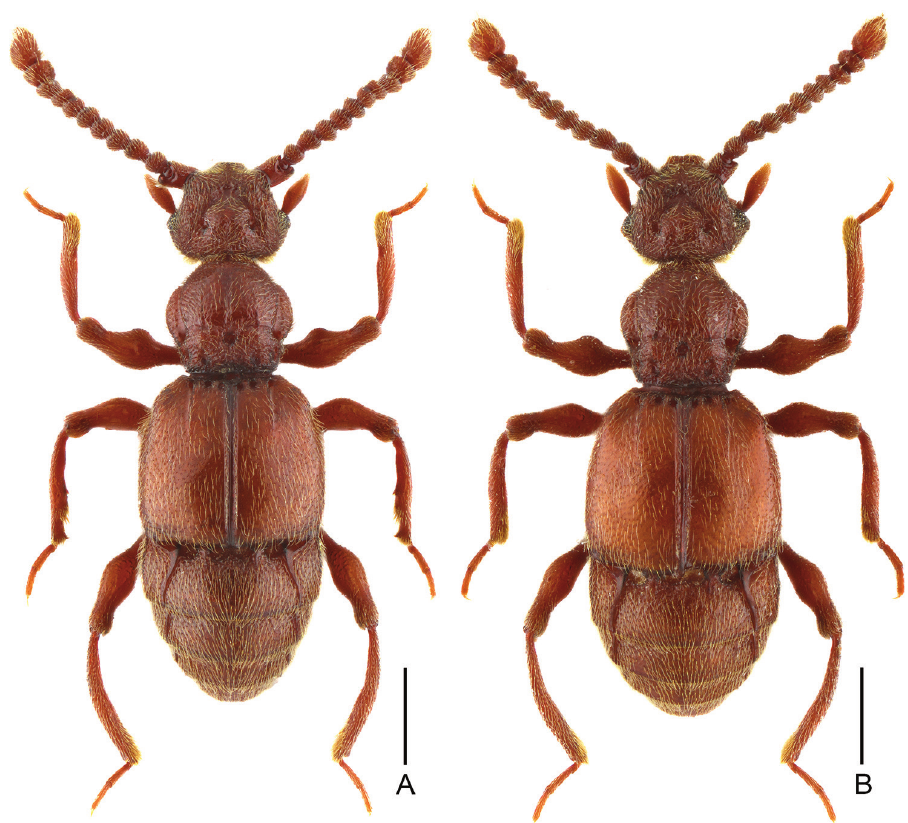
Figure 8. Dorsal habitus of Batrisodes xuhaoi . A Male B Female. Scale bars: 0.5